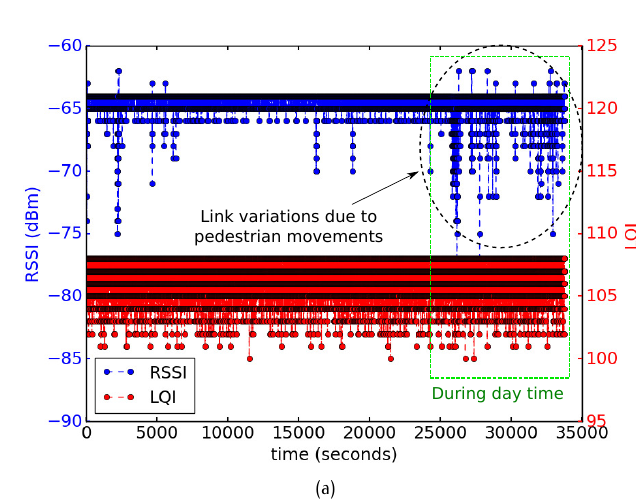
Figure 13. RSSI and LQI variations during night and day times maximum quality and 50 indicates lowest quality frame for